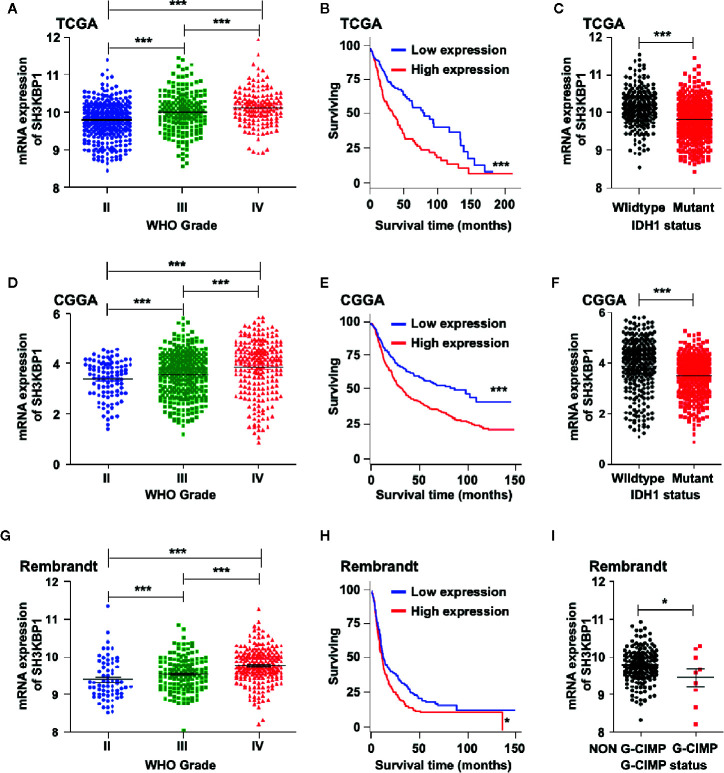
SH3KBP1 is highly expressed in GBM. (A) The expression of SH3KBP1 in glioma was increased with the tumor grade in TCGA data set. (B) High expression of SH3KBP1 predicts worse survival of glioma patients in TCGA data set. (C) SH3KBP1 expression was highly expressed in Isocitrate dehydrogenase1 (IDH1) wild-type gliomas than mutant gliomas in TCGA data set. (D) SH3KBP1 expression was correlated with glioma grades in CGGA datasets. (E) Elevated expression of SH3KBP1 predicts poor survival of glioma patients in CGGA data set. (F) SH3KBP1 was highly expressed in IDH1 wild-type gliomas than mutant gliomas in CGGA data set. (G) The expression of SH3KBP1 in glioma was increased with the tumor grades in Rembrandt data set. (H) High expression of SH3KBP1 predicts unfavorable survival of glioma patients in Rembrandt data set. (I) SH3KBP1 was highly expressed in NON G-CIMP than G-CIMP gliomas in Rembrandt data set. Lines show mean and S.E.M. Log-rank (Mantel-Cox) test was used to analysis the difference of Kaplan-Meier survival analysis. *, ** and *** indicate as p < 0.05, p < 0.005 and p < 0.001 respectively.